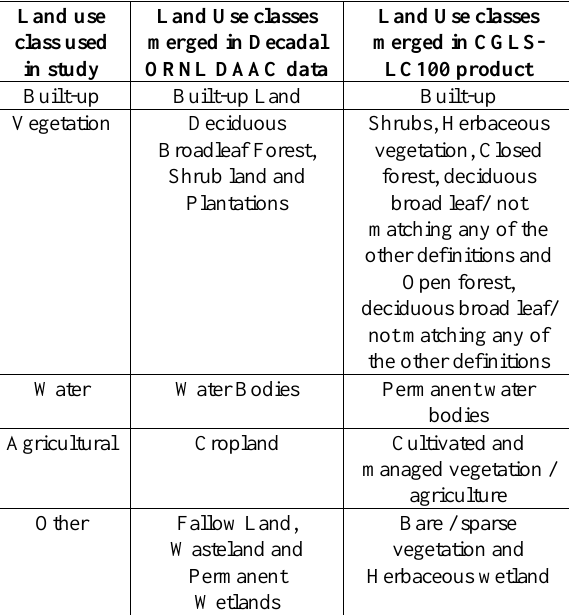
Table 1. Land use classes defined in